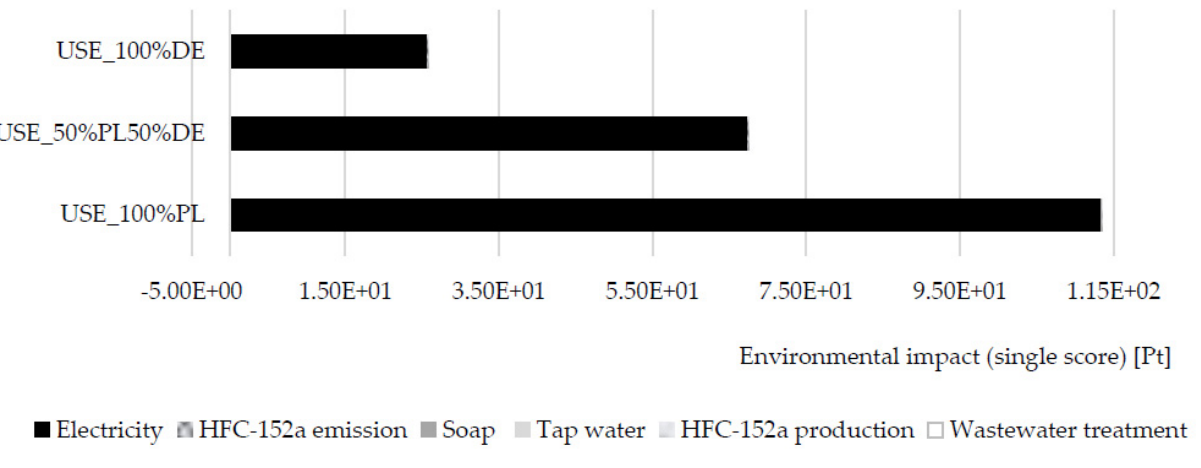
Figure 5. Environmental impact of the life cycle stage Use (USE) per 1 refrigerator (25.827 Pt = 100%DE, 67.514 Pt = 50%PL50%DE, 113.496 Pt = 100% PL, decrease by 77%).